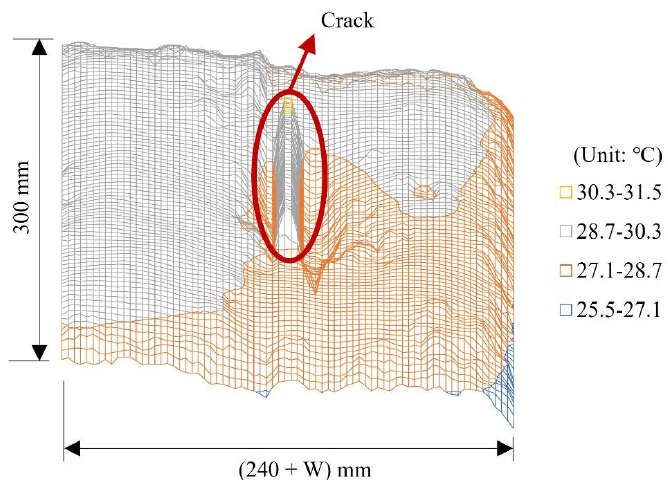
Figure 5. Example of 3D visualization for temperature distribution at the concrete surface. Table 3. Example of raw data.